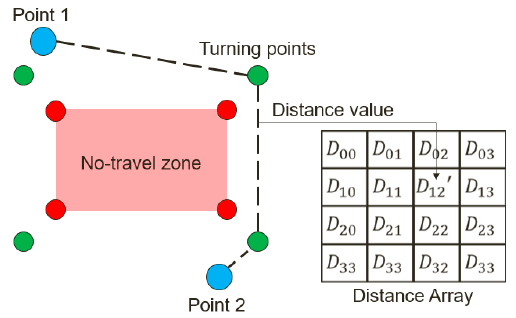
Figure 10. Schematic diagram of avoiding the no-travel zone.